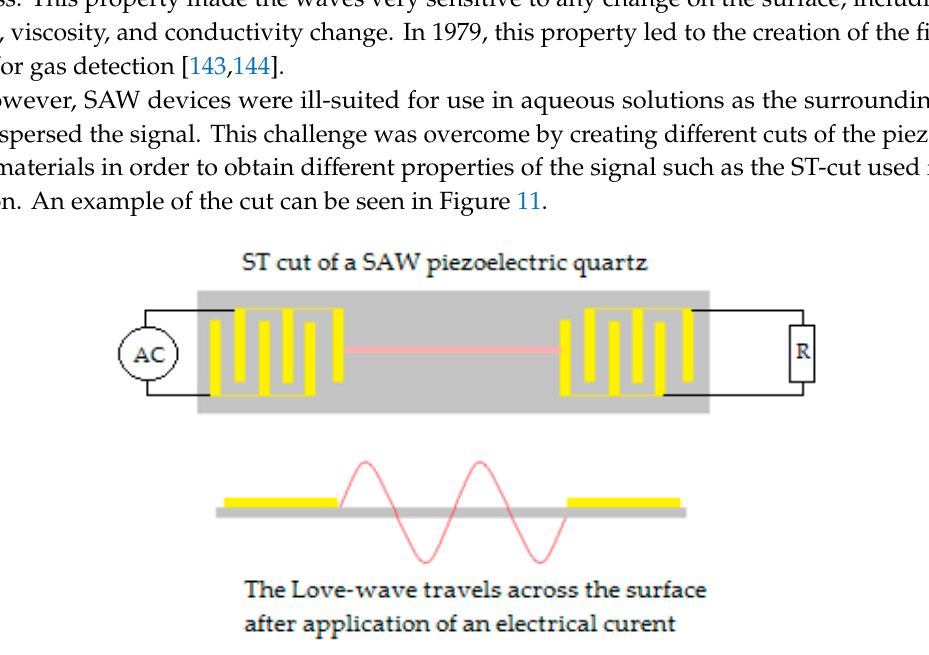
Figure 11. Graphic representation of surface acoustic wave (SAW) biosensors with an ST-cut.